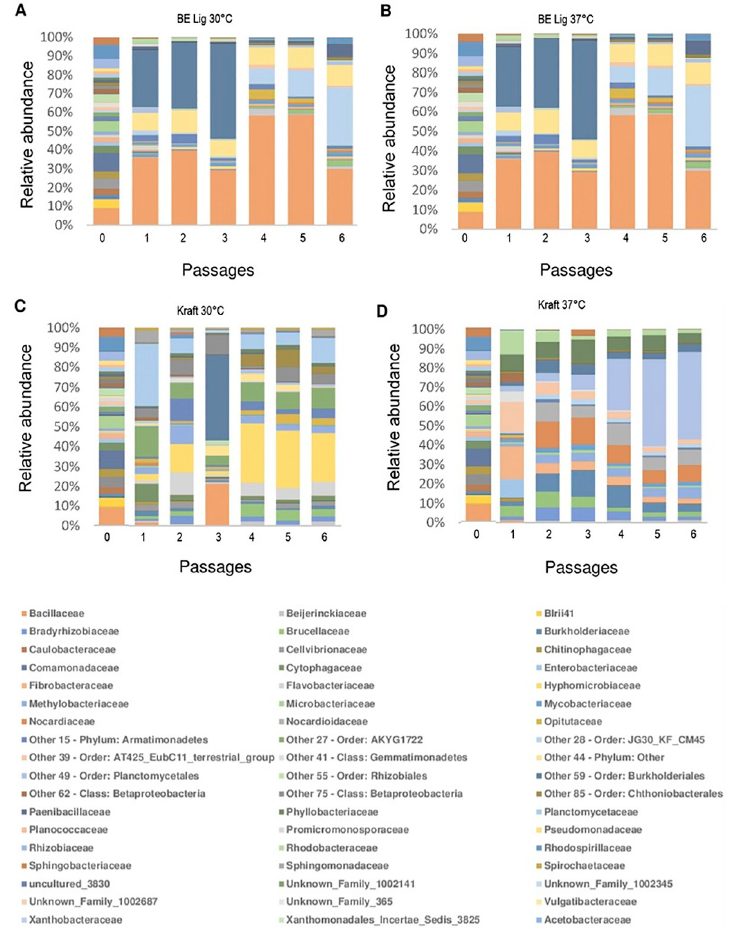
Fig 3. Family level taxonomic profile of bacteria at present in consortia obtained from backyard (BY) soil over successive passages in enrichment experiment. M9 medium containing either base-extracted lignin, BE Lig, (panels A and B) or Kraft lignin (panels C and D) was initially inoculated with backyard (BY) as the source of microorganisms. Experiments were performed at two temperatures. 30˚C (panels A and C) and 37˚C (panels B and D). Every 2 weeks an aliquot was transferred to fresh growth medium for enrichment in successive passages (0, 1, 2, 3, 4, 5 and 6). Bacterial families are depicted by different colors. For the families classified as Other and Unknown, we were unable to obtain the taxonomic affiliation at the family level, so the closest previous hierarchical level is